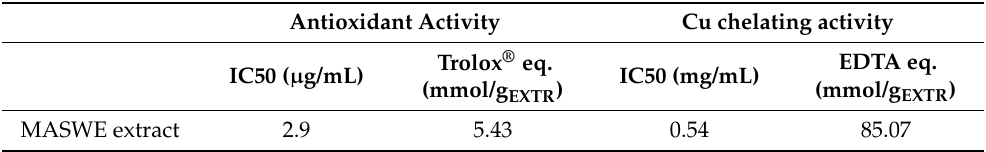
Table 6. MASWE optimized extract characterization: antioxidant activity and Cu chelating activity (expressed as IC50 and Trolox ® eq. and EDTA eq., respectively).